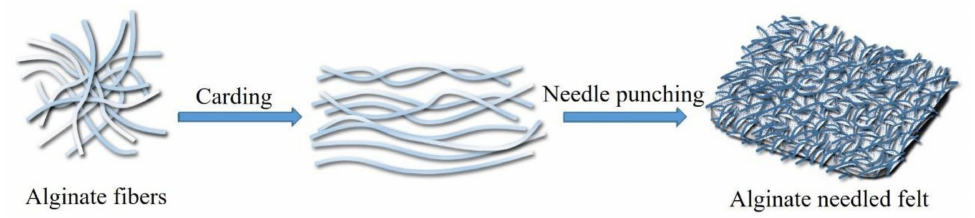
Figure 3. Fabrication of the alginate hydrogel and its porous scaffold by combining ionic cross-linking and freeze-drying techniques.